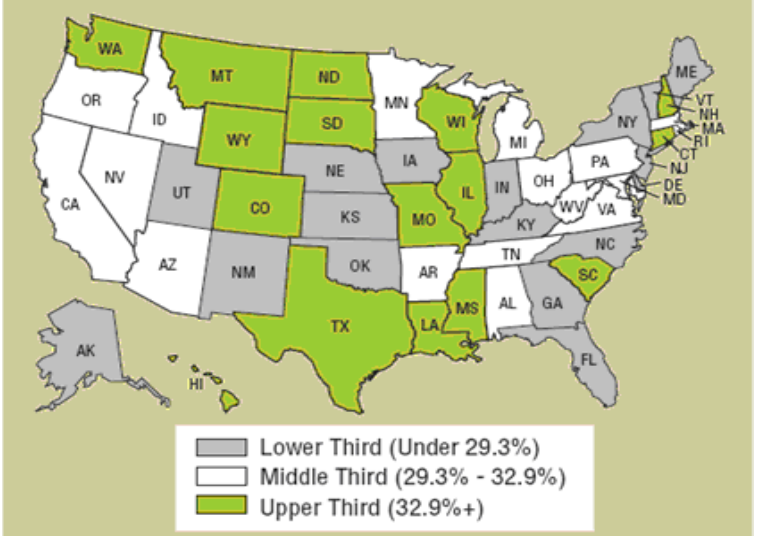
Figure 2. Fatalities as a percentage of total fatalities in crashes involving at least one driver with a BAC =0.08+, 2006 (Source: